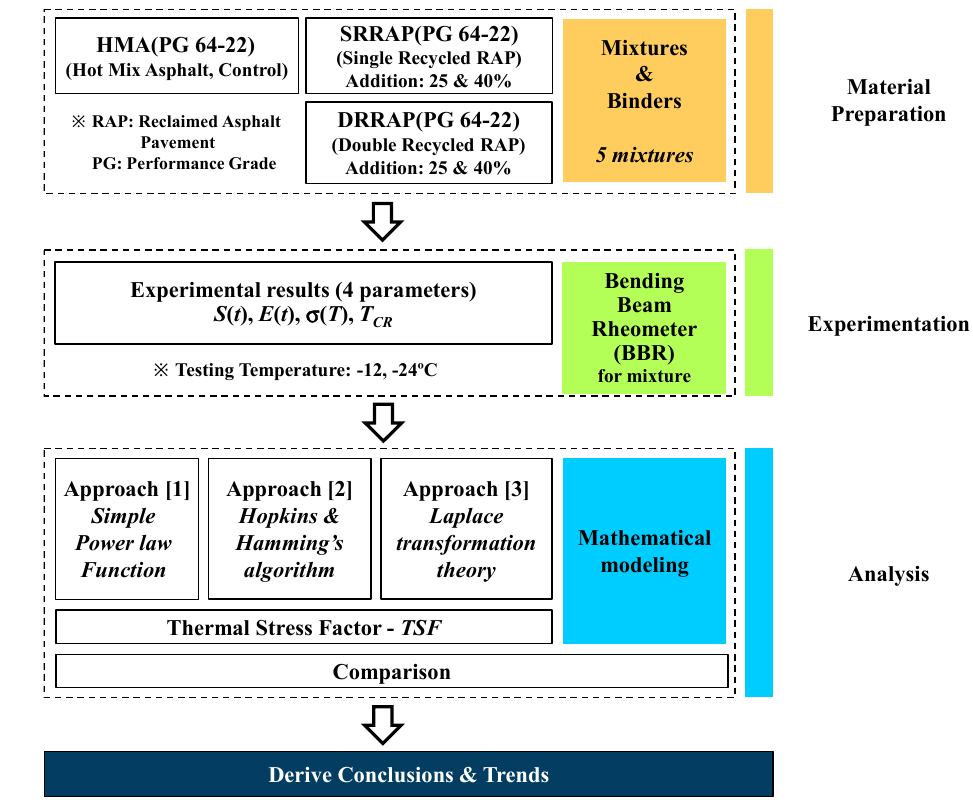
Figure 1. Schematic flow chart of the research approach.